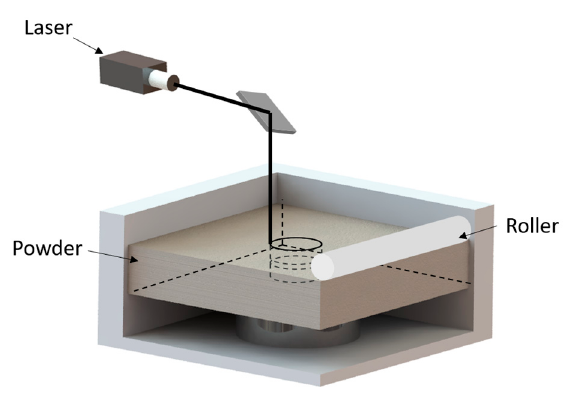
Figure 15. Schematic diagram of selective laser sintering manufacturing process.